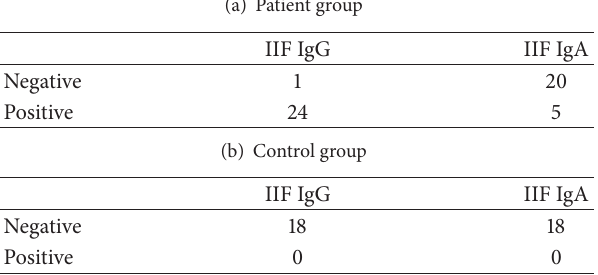
Figure1:Atypicalp-ANCA(serumofpatientwithdiagnosisoffood protein-induced proctitis/proctocolitis).